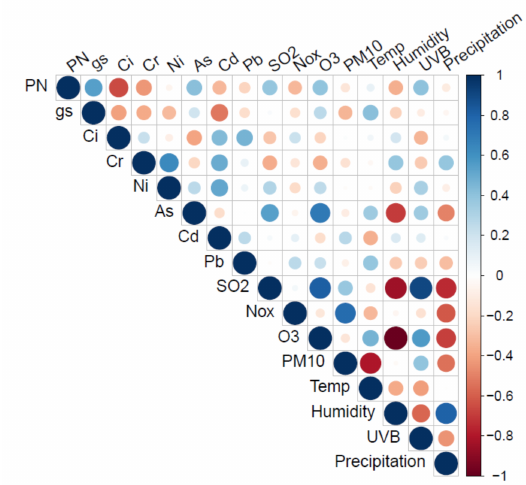
Figure 6. Matrix of correlations between photosynthesis activity parameters, trace elements accumulations, meteorological parameters, and other air